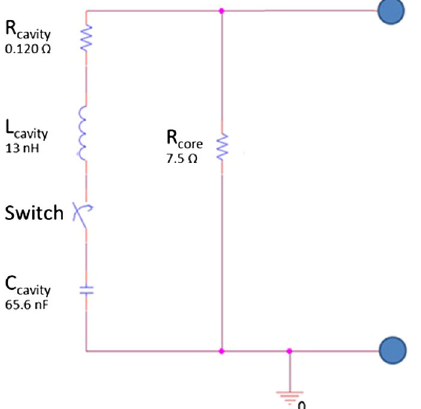
FIG. 2. Simplified circuit model of each LTD cavity. The right part is connected to the LSP grid across the inlet boundary.